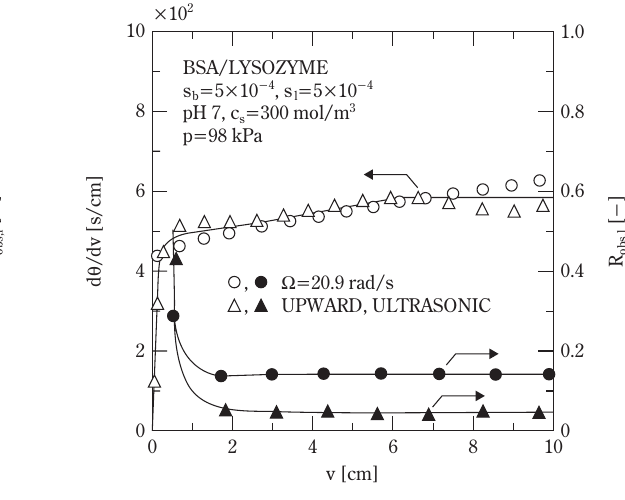
Fig. 28 Comparison of apparent lysozyme rejection between cases with and without ultrasonic irradiation in which similar filtration rate are